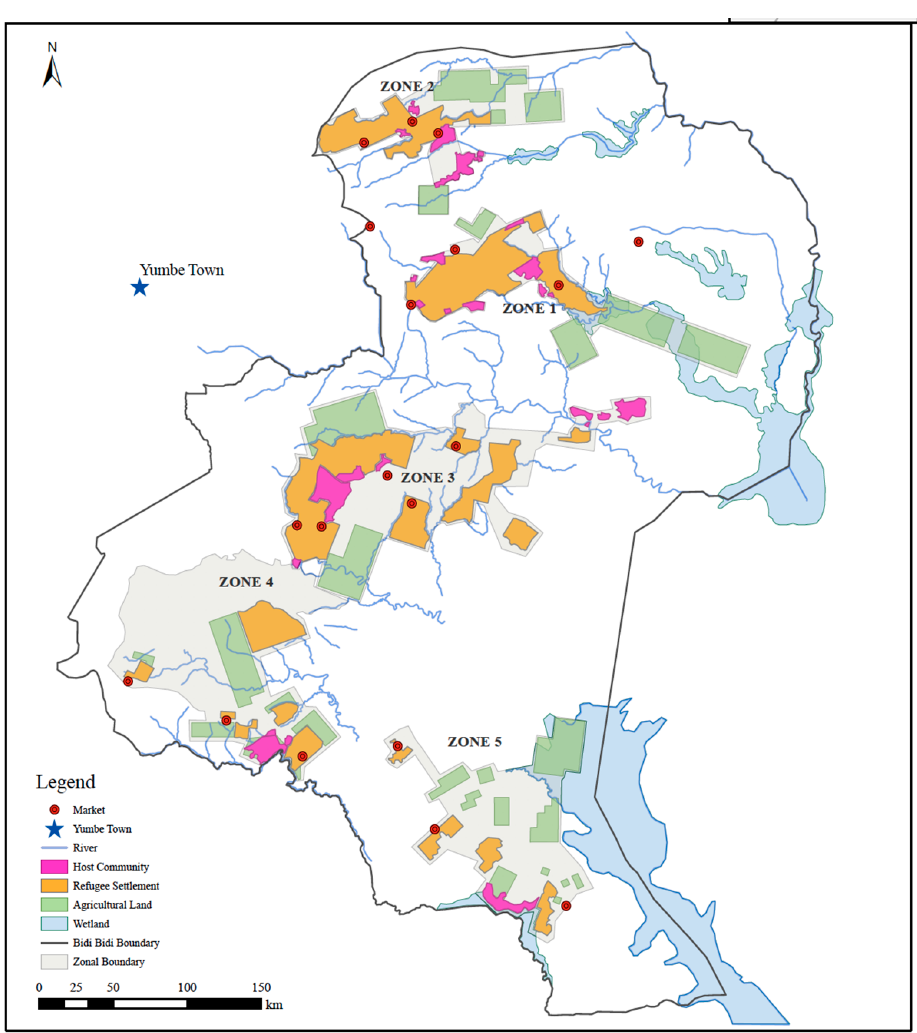
Figure 6. Map of the Bidi Bidi settlement. The map was created using UNHCR documents and